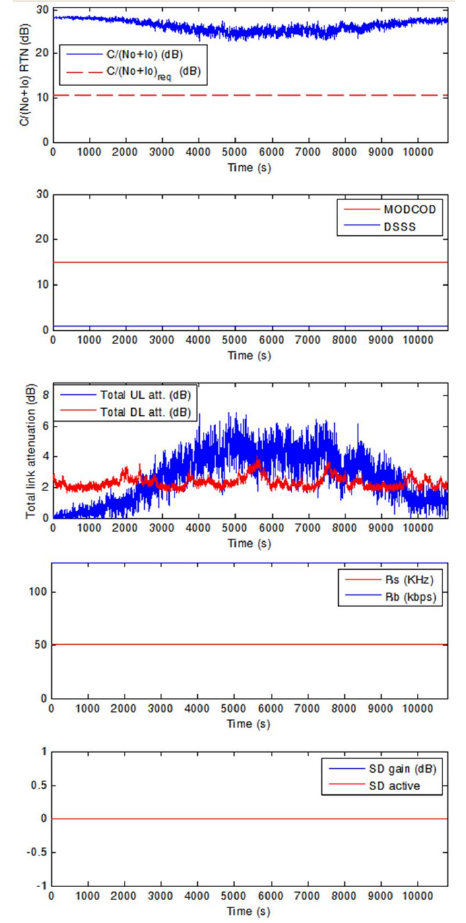
Figure 8. Adaptive strategy operation for UTB terminals in Ku